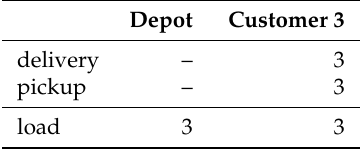
Table 1. Vehicle load of the tentative route 0 − 3 −